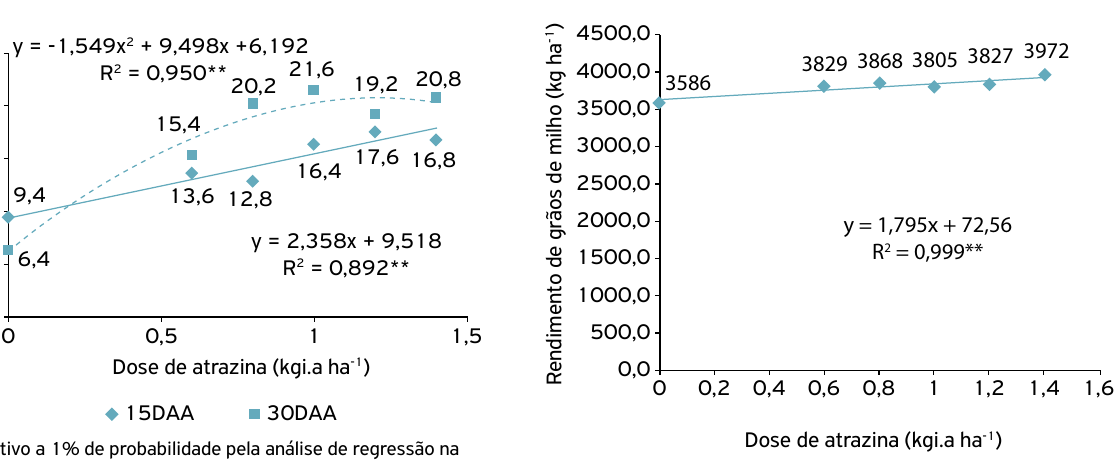
Figura 3. Massa seca (g) de Brachiaria ruziziensis após a aplicação de diferentes doses de atrazina na cultura do milho safrinha consorciado com Brachiaria ruziziensis . Maracaju, Mato Grosso do Sul, 2013.